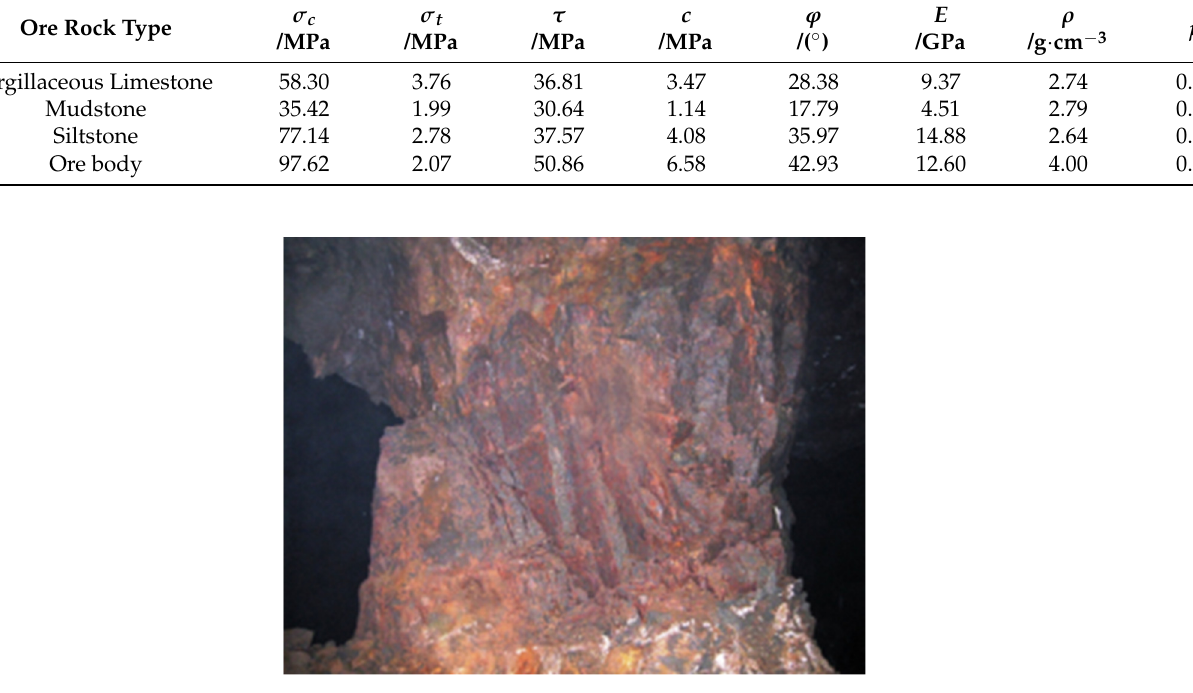
Figure 3. Picture of pillar in Bainiuchang mine.